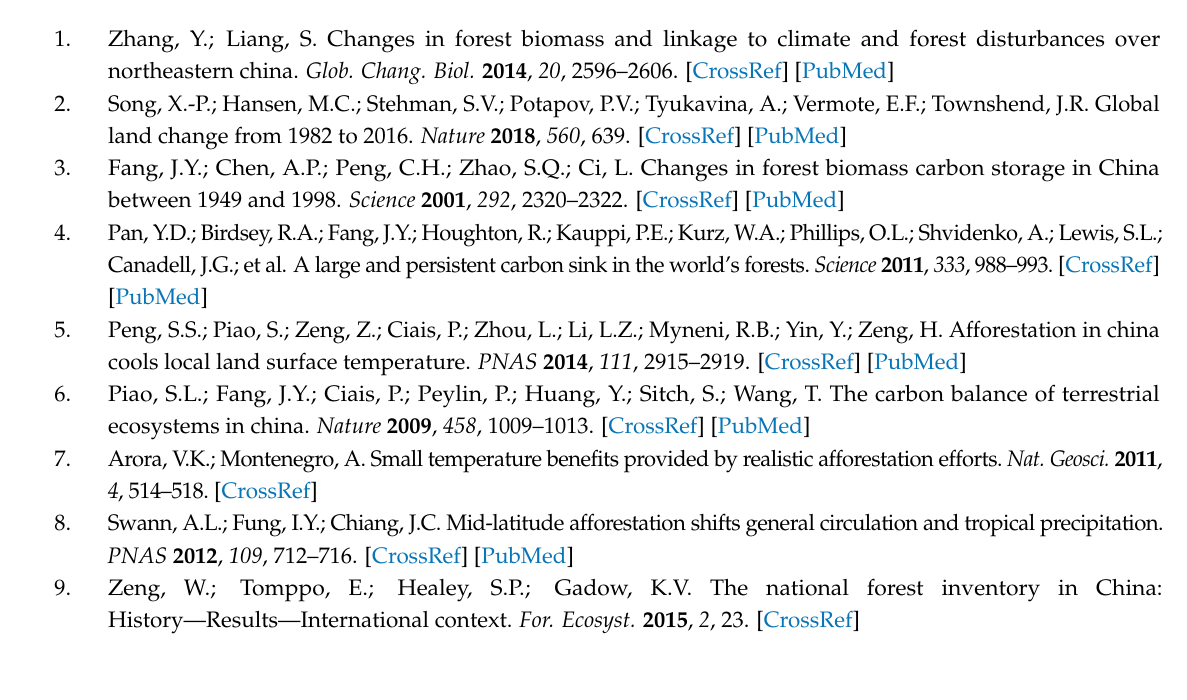
Figure S1: Statistics of the number of Landsat images used by (a) 12paths/rows, (b) 12 months, (c) 3 sensors, and (d) dry season and wet season from Shen et al. (2018), Code S1: Taking a case of the PALSAR-based SVM land cove type classification by traditional classification and parallel processing classification techniques, Table S1: The accuracy assessment of land cover classification in 2007 and 2016, Figure S2: The 2007 land cover classifications based on SVM (a), RF (b), SGB (c), and C5.0 (d) in the Guangdong province of China, Table S2: The accuracy assessment of forest and non-forest in 2005, 2010, and 2016, Table S3: Validation results of different forest and non-forest products in